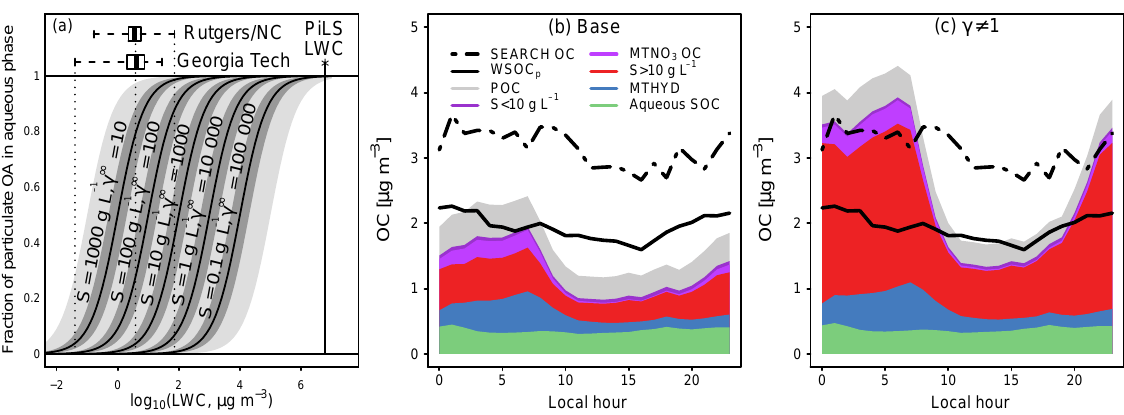
Figure 13. Fraction of OA present in aqueous phase (a) as a function of activity coefficient at infinite dilution and observed OC and WSOC p at CTR compared to model predictions (b–c) . Panel (a) boxplots indicate observed LWC from Rutgers/NC State (Nguyen et al., 2014b) and Georgia Tech (Guo et al., 2015) during SOAS. For predictions (a) , WIOA is 1µgm − 3 and the species molecular weight is set to 180gmol − 1 . Predictions in dark grey shading span a factor of 2 in WIOA (0.5 to 2µgm − 3 ). Predictions in light grey shading (a) indicate a factor of 10 in WIOA (0.1 to 10µgm − 3 ). Panel (b) corresponds to model predictions in the base simulation, while panel (c) corresponds to predictions > 1000 (solubilities less than in the γ (cid:54)= 1 simulation. Model predictions of OC are stacked and divided into POC, compounds with γ ∞ i < 1000 (solubilities greater than 10gL − 1 ), the organic nitrate hydrolysis 10gL − 1 , Table 2), monoterpene nitrate OC, compounds with γ ∞ i product, and aqueous